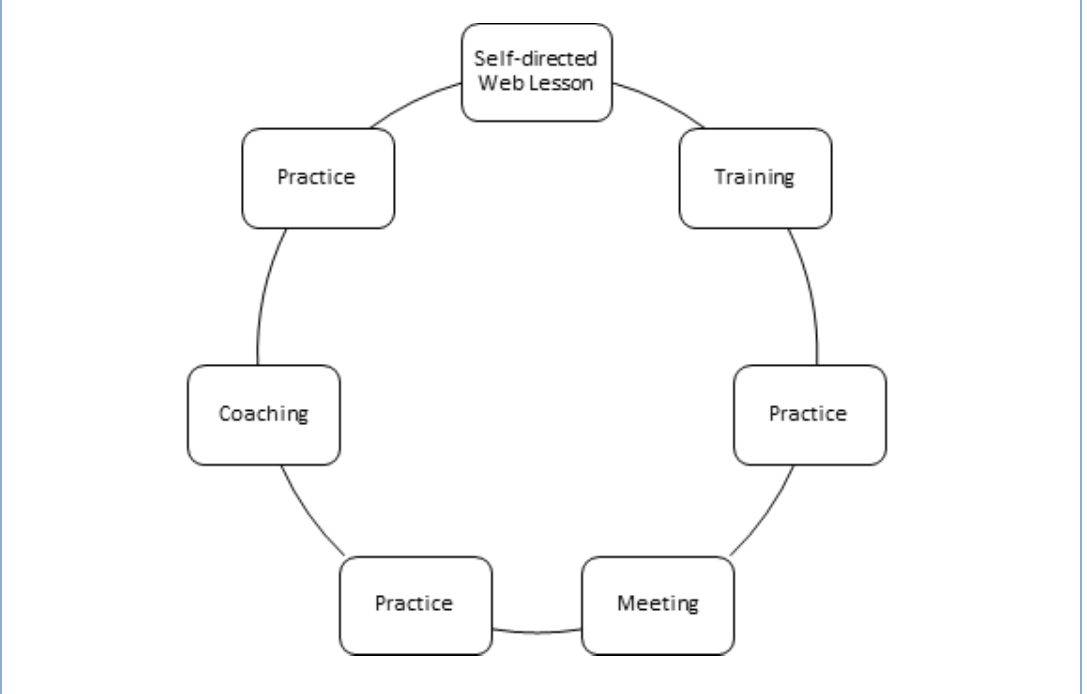
Figure 1. The Click2SciencePD Professional Development